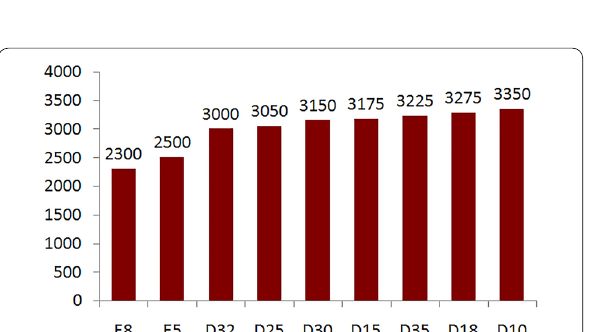
Fig. 11 Average price in euro per square meter for civil housing in very good condition per OMI zone. Revenue Agency data 1°